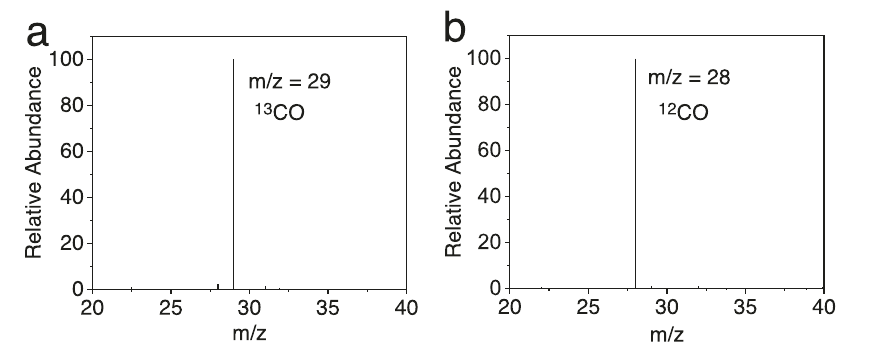
Fig. 6 GC/MS chromatograms of carbon monoxide. Photocatalytic CO 2 reduction in 13 CO 2 -saturated ( a ) and 12 CO 2 -saturated ( b ) DMF